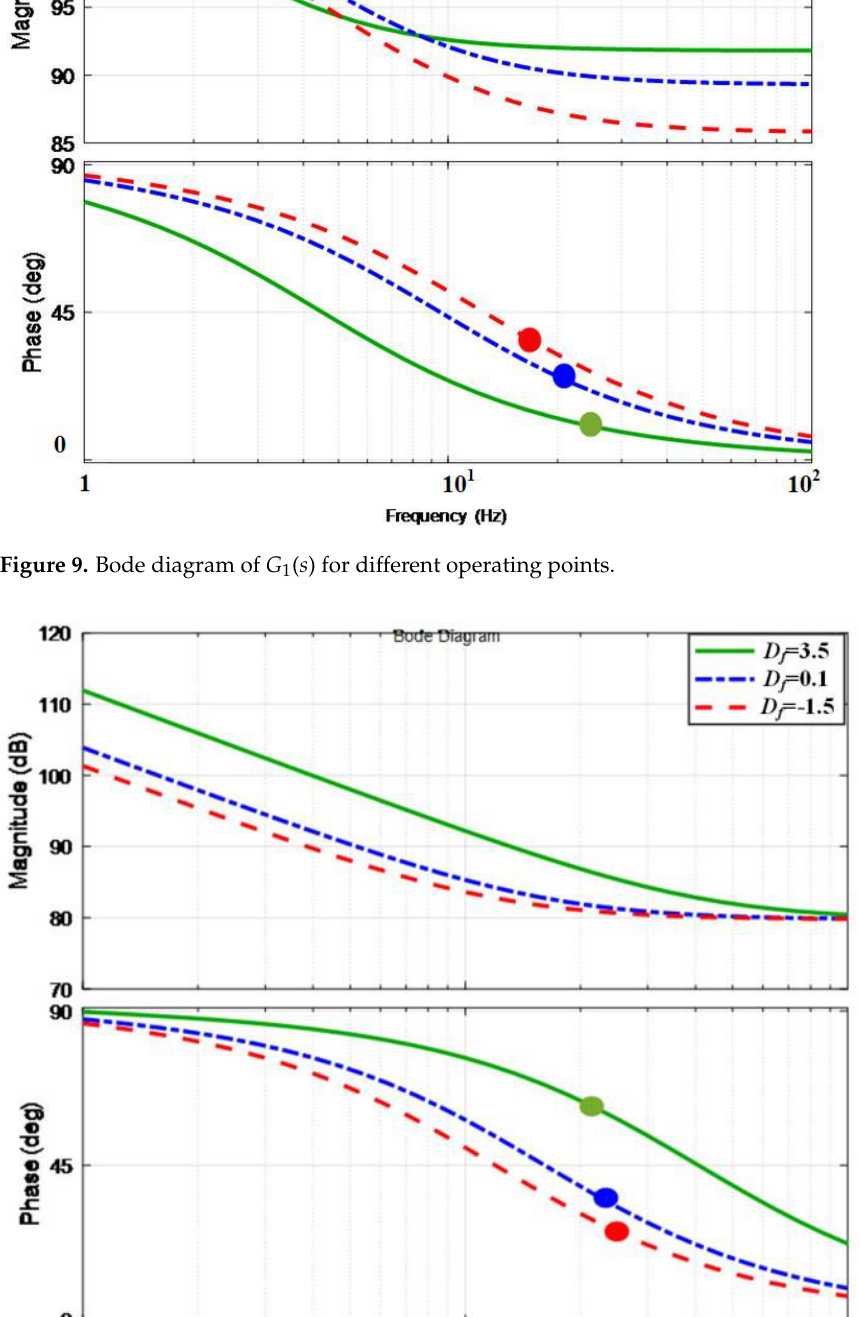
Figure 11. Bode diagram of G 1 ( s ) for different grid strengths. In order to assess whether the results based on internal voltage stability are valid, the Bode diagram with the open-loop transfer function G 2 (s) is addressed. G 2 (s) is defined as 2 ( ) e m T G s